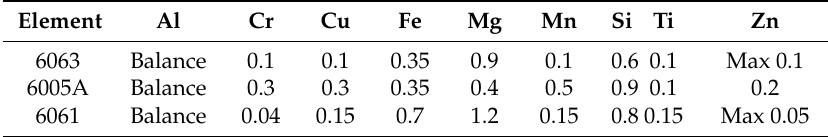
Table 1. Nominal composition (weight pct.) of the chosen 6XXX aluminum alloys [8].